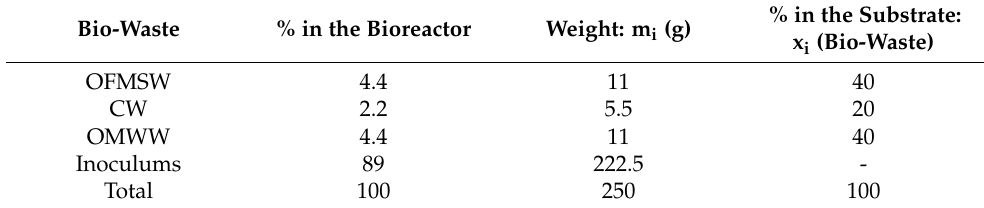
Table 1. Bio-wastes composition in the bioreactor and in the substrate.